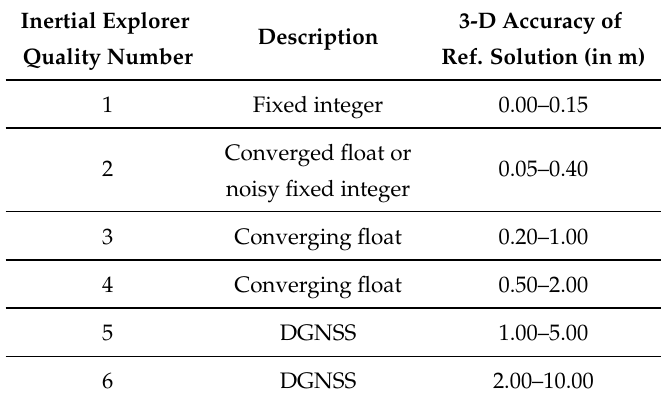
Table 9. Quality Number Description and Associated 3-D Accuracy for Novatel’s Waypoint-Inertial Explorer